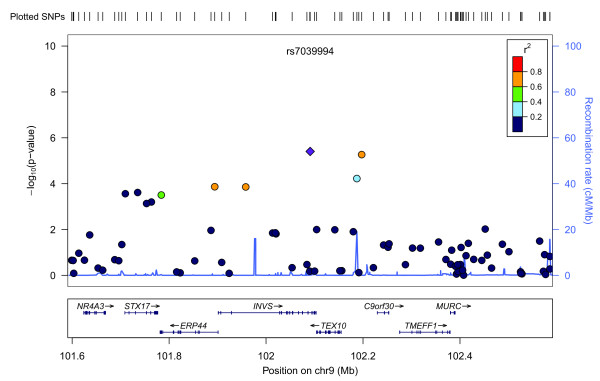
Plot of regional association signals for rs7039994 forwarded for validation.